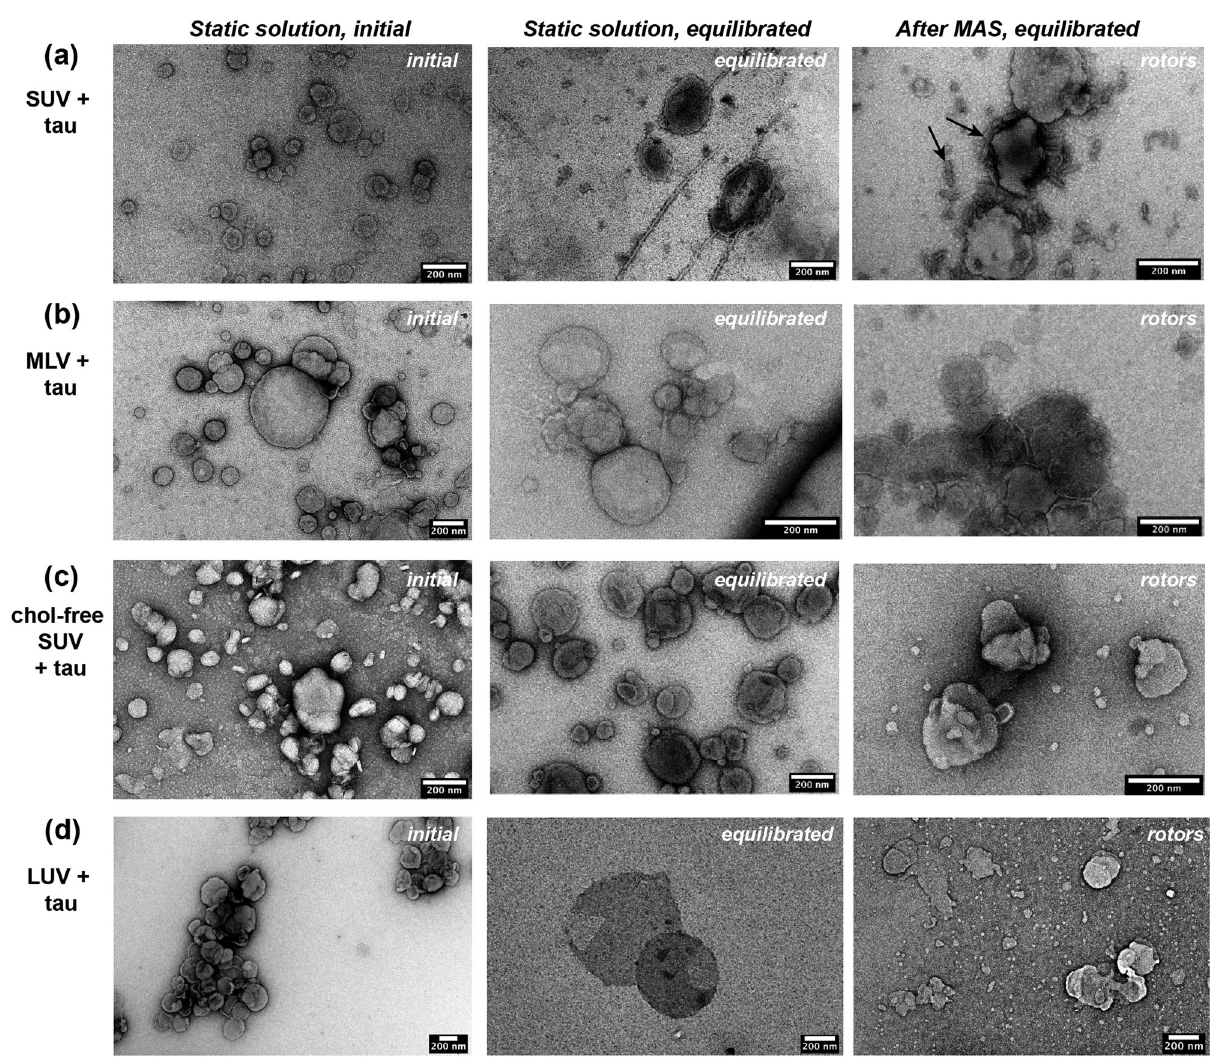
Fig. 2 Negative stain TEM images show the initial and equilibrated morphologies of tau-bound lipid vesicles. a SUV-bound P2R tau. b MLV-bound P2R tau. c Cholesterol-free SUV-bound P2R tau. d LUV-bound P2R tau. All scale bars are 200 nm. Left column: images of unshaken and freshly prepared membrane vesicle solutions. Middle column: images of unshaken vesicle solutions that have equilibrated for several weeks. Right column: images of samples that have been spun in the MAS rotor for several weeks. Tau-bound SUVs develop long and 15-nm wide fi brils that stem from the vesicles in static solution. After MAS, short fi brils of 50 – 70 nm long are observed on the surface of the SUVs. Tau-bound MLVs have diameters of 200 – 600 nm and do not exhibit fi laments in the mature state. Tau-bound cholesterol-free SUVs do not show fi brils. In all images, membrane vesicles remain mostly intact. A detailed description of these samples is given in Supplementary Table